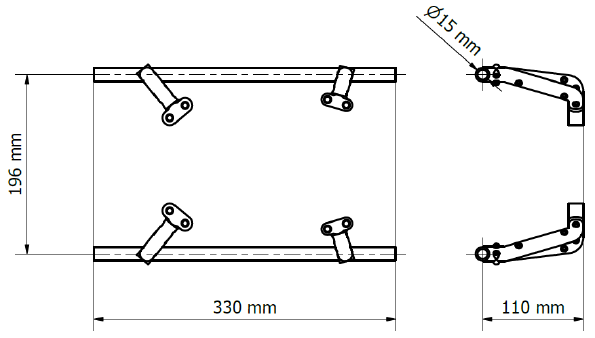
Figure 8. Ski-style landing gear for the Shafter drone.